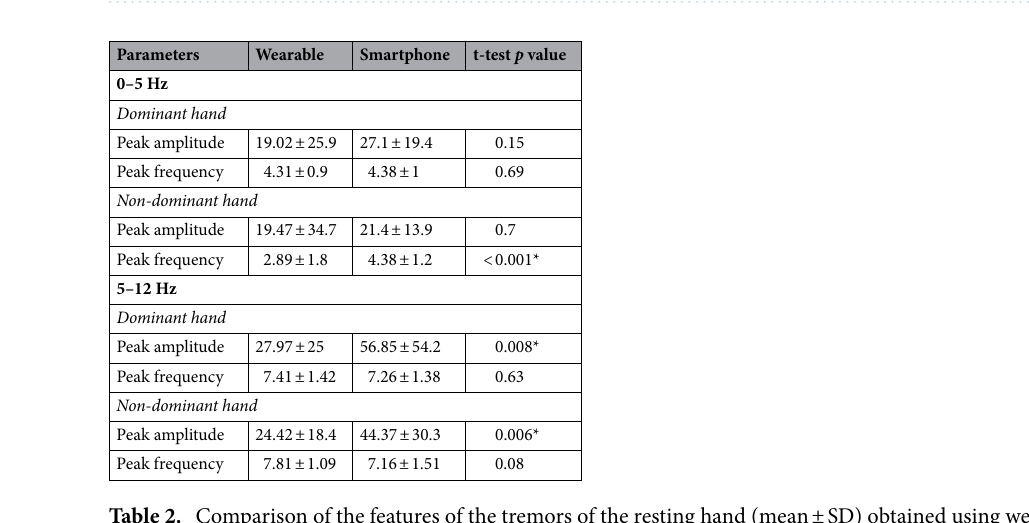
Figure 2. Power spectrum of tremor at rest recorded by smartphone in the dominant hand ( a ), lightweight wearable in the dominant hand ( b ), and comparison between both devices in the dominant hand ( c ). ( d ), ( e ) and ( f ) represent similar plots for non-dominant hand recordings.